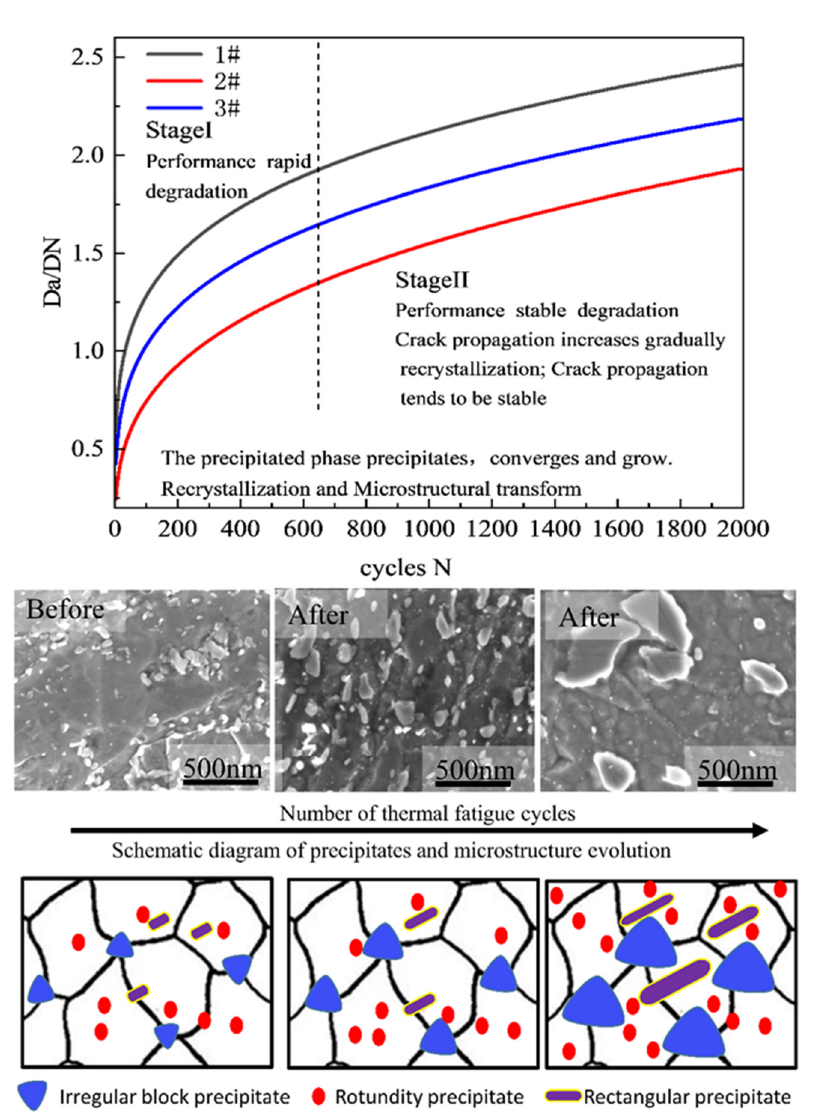
Figure 13. Thermal fatigue cracks propagation model and schematic diagram of precipitate and microstructure evolution.